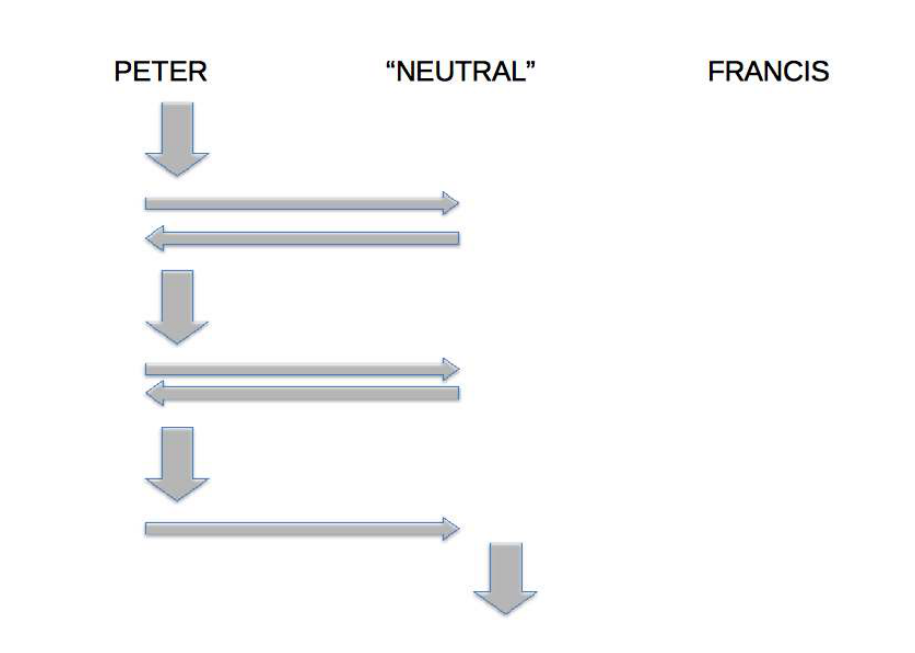
Figure 2. Part two of the story is almost exclusively set from Peter’s PoV and ends with a ‘neutral’ focalization in the last